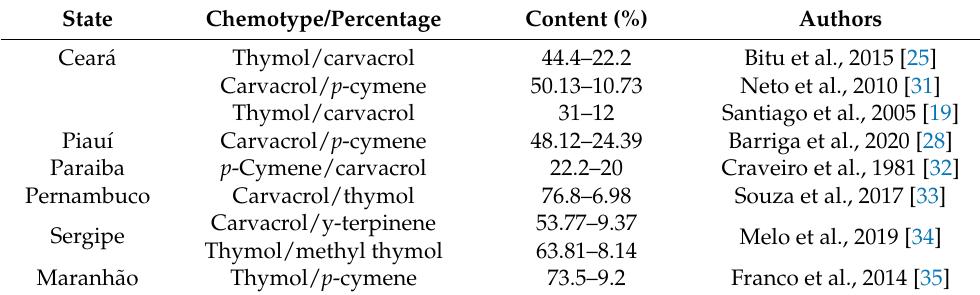
Table 2. Main chemotypes of Lippia grata Schauer in the Brazilian States situated in Northeast- ern